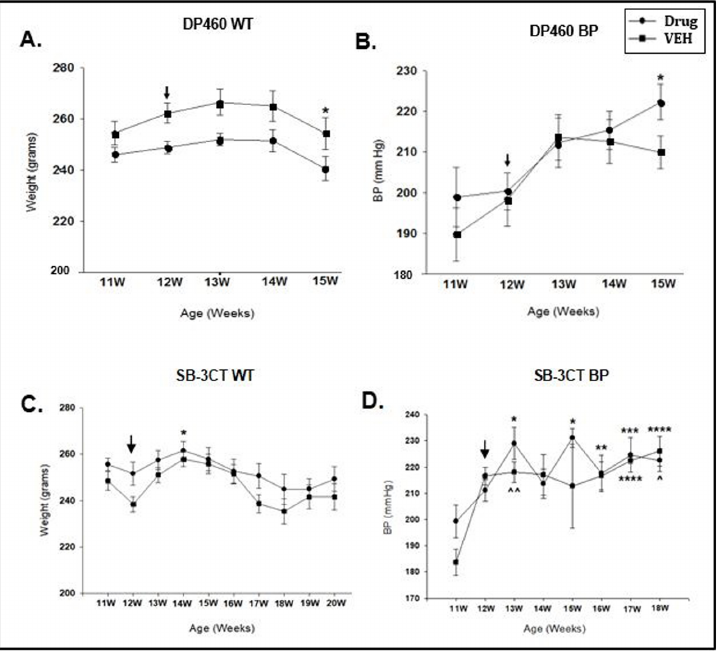
Fig 1. Distribution of WT and BP data for DP-460 and SB-3CT drug study animals. (A). Timecourse of WT distribution for SHRSP/JPD/UCAO treated with the DP-460 drug compared with 5% dextrose-treated control rats. Significantly lower WT was detected at 15 weeks in treated rats compared to the 13 week ( � p = 0.004) and 14 week ( � p = 0.011) VEH group. (B). Timecourse of BP distribution in SHRSP/JPD/UCAO treated with the DP-460 drug compared with 5% dextrose-treated control rats. BP was significantly elevated at 15 weeks in drug versus 11 weeks vehicle group ( � p = 0.007). (C). SB-3CT WT distribution over 20 weeks of rat life compared to the VEH group. Higher WT was found at 14 weeks in the SHRSP/JPD/UCAO drug group compared to 18 weeks in the DMSO-treated VEH group ( � p = 0.015). (D). A BP timecourse for SB-3CT comparison with DMSO-treated VEH shows several significant findings: drug at 13 week ( � p < 0.001), 15 week ( � p < 0.001), 16 week ( �� p = 0.050), 17 week ( ��� p = 0.004) and 18 week ( ���� p = 0.009) compared to 11 week VEH; VEH at 13 week (^^p = 0.043), 17 week ( ���� p = 0.009), 18 week (^p = 0.002) compared to 11 week VEH. Data is based on drug (n = 20) and VEH (n = 5) groups for DP-460 and SB- 3CT studies, respectively. The black arrow at the 12 week timepoint per graph represent the beginning of the JPD. Week